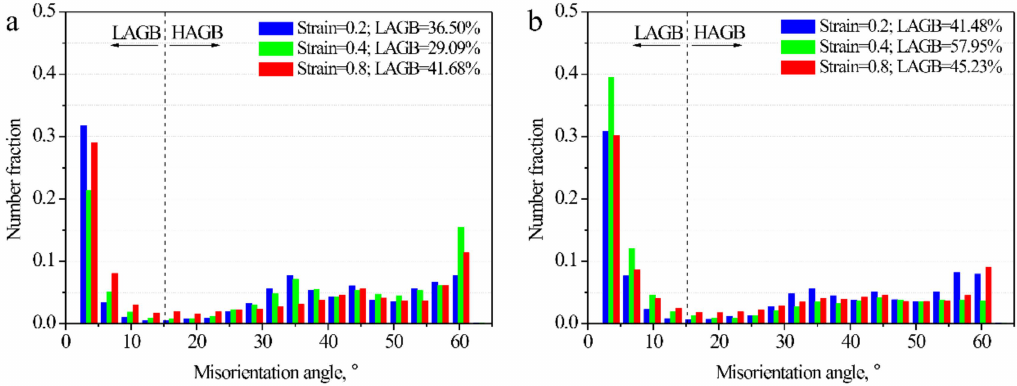
Figure 6. Distribution of misorientation angles of specimens deformed at 10 − 3 s − 1 and different constant temperatures: ( a ) 1423 K; ( b ) 1323 K.